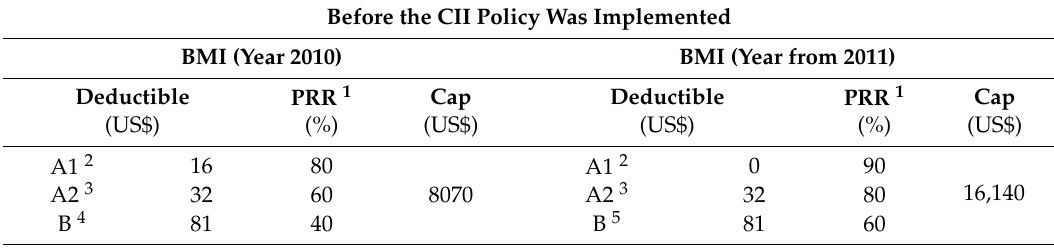
Table 1. Policy changes before and after the critical illness insurance (CII) policy was